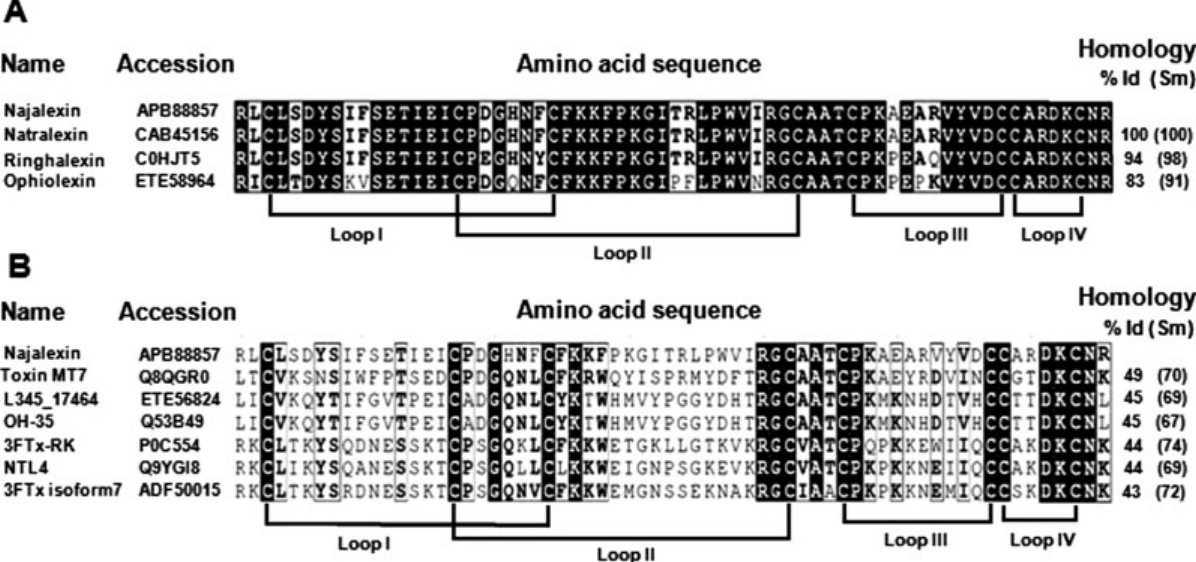
Fig. 2 Multiple sequence alignment of najalexin with 3FTxs. ( A ) Identity and similarity among orphan group I 3FTxs. ( B ) Similarity with other closely related 3FTx homologues obtained from BLAST search against the NCBI database. Toxin names, accession numbers, and amino acid sequencealongwithpercentage of identity andsimilarityofeachproteinsequence comparedwithnajalexinare shown. Conservedresidues inall sequences are highlighted in black and the disul fi de bridges and loops are